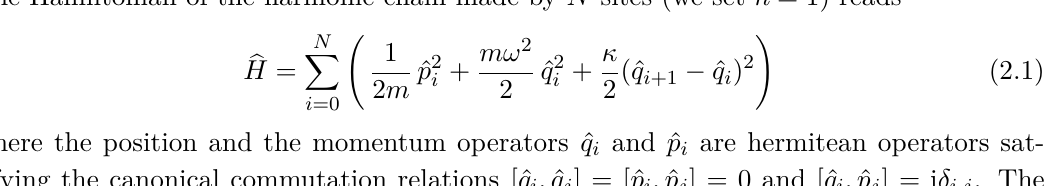
Figure 1 . The local quench considered in this manuscript: two harmonic chains containing N and N = (1 − r ) N sites are joined together at t = 0 into a single chain made by N ≡ N r sites (top panel). The subsystem A is a block of L consecutive sites (red segment), either adjacent to the left boundary (bottom left panel) or centered at the midpoint of the chain, when r = 1 / 2 (bottom right